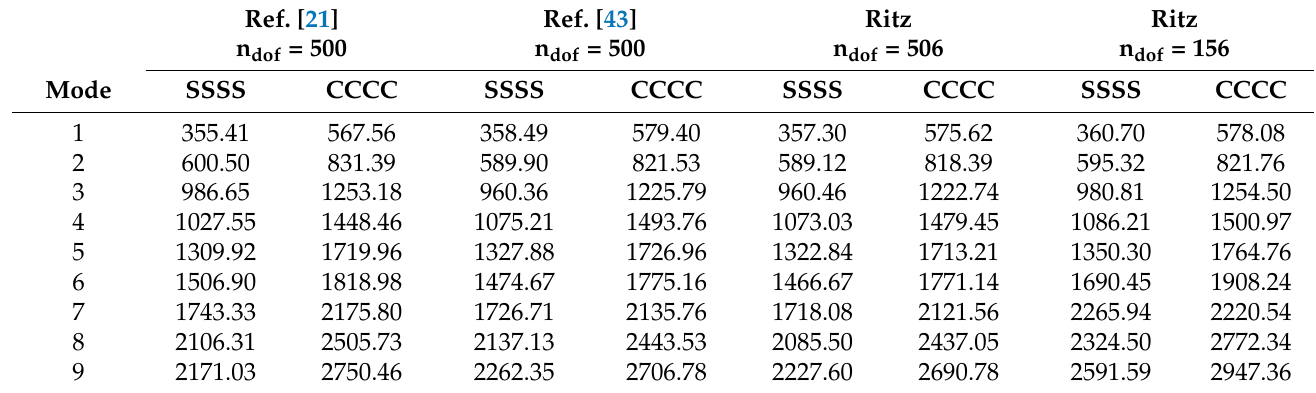
Table 3. Natural frequencies (rad/s) for VS plates: comparison with [21,43].